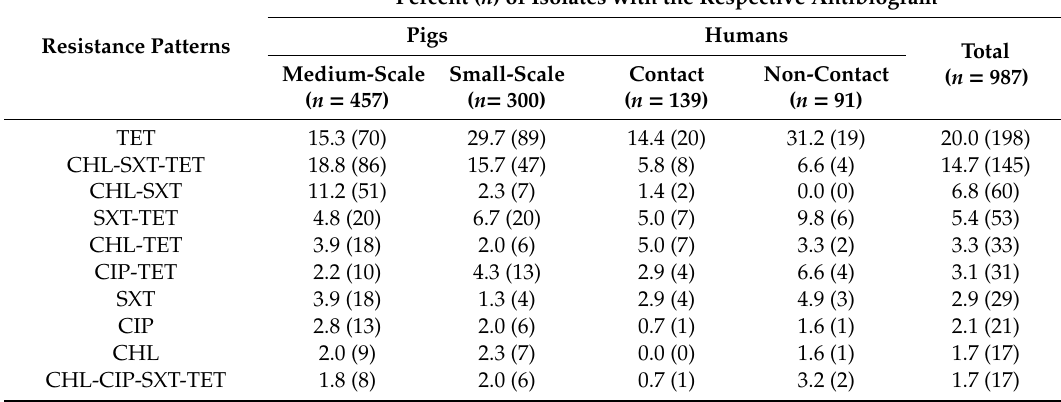
Table 3. Ten most common antibiograms of E. coli isolates from pigs and contact and non-contact humans at small- and medium-scale farms in North eastern